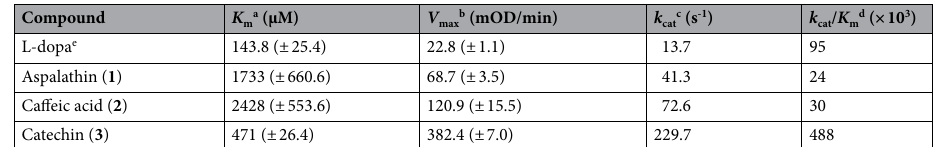
Table 3. Substrate properties of compounds from Aspalathus linearis , on tyrosinase. a Michaelis constant. b Maximum velocity. c Catalytic constant. d Catalytic efficiency. e Native substrate.